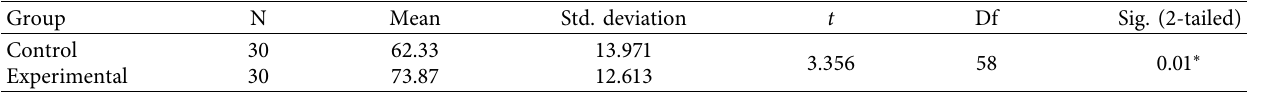
Table 4: Independent-samples t -test results for the differences in the mean scores between the control group. Group